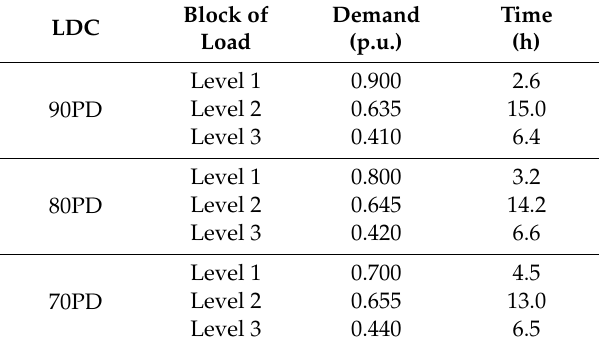
Table 8. Information on load duration curves used for the load representation of demand in the di ff erent scenarios.